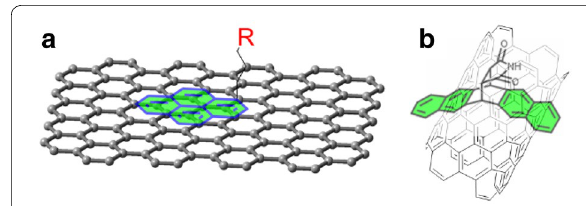
Fig. 2 Schematic representation of a pyrenyl moiety sitting on the basal plane of graphene ( a ) and a Diels-Alder adduct of pentacene tweezing a single-walled carbon nanotube ( b ) through π–π